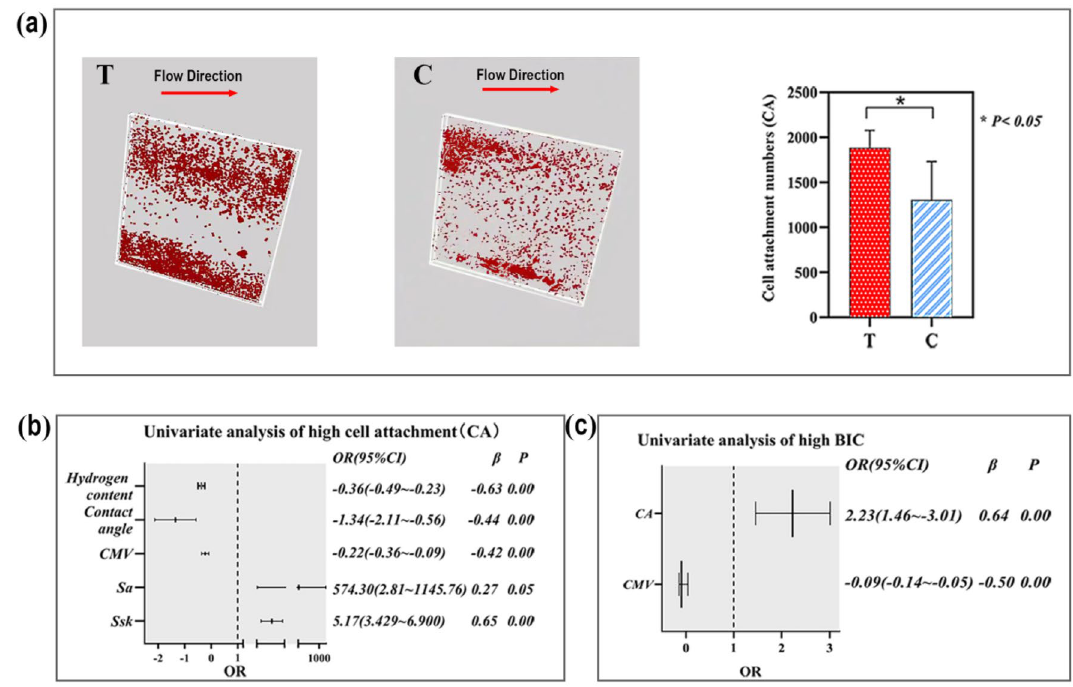
Figure 4. The cell movement velocity (CMV) down-regulated the cell attachment number (CA) of MG-63 cells. ( a ) Images and diagram of attached MG-63 cells at the bottom of TOC-T and TOC-C with a magnification of 20×. ( b ) Factors contributing to high CA: Sa and Ssk played positive roles in the high CA, accounting for 27% and 65%, respectively ( P < 0.05). The CMV, contact angle, and hydrogen content were negative factors for high CA, accounting for − 42%, − 44%, and − 63%, respectively ( P < 0.05). ( c ) The CA was a positive factor for high BIC, accounting for 64% ( β = 0.64, P = 0.00); the CMV was a negative factor for the high BIC, accounting for − 50% ( β = − 0.50, P = 0.00). The statistical significance was set at P < 0.05. This figure was generated by Adobe photoshop CC